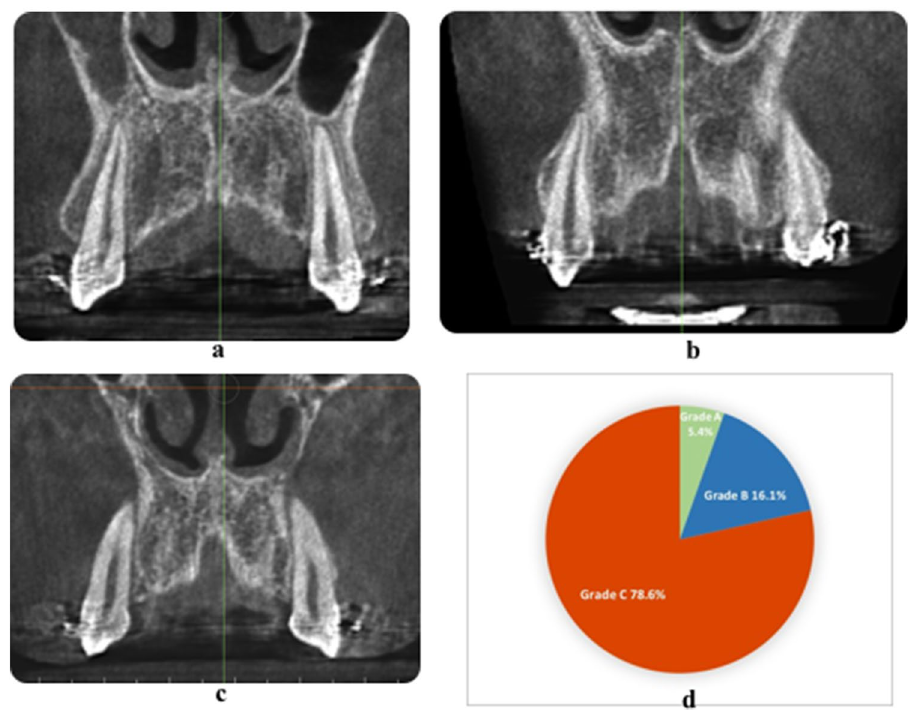
Figure 2. (a) CRCR Grade A: the canine root and root apex totally present inside the medullary bone leaving a continued thickness of the overlying cortical bone. (b) CRCR Grade B: the canine roots or root apices in contact with the overlying cortical bone, with thinning of the overlying cortical bone. (c) CRCR Grade C: penetration of the canine roots of the overlying cortical bone, and loss of the continuity of the cortical bone (fenestration or deep dehiscence). (d) Proportional percentage of each of CRCR